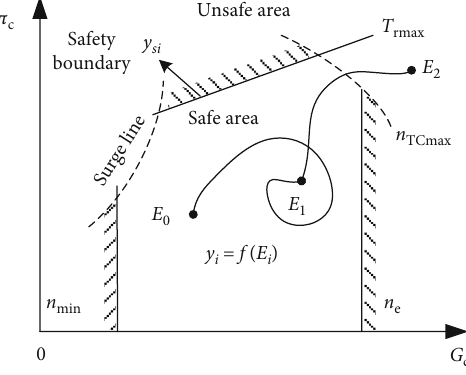
Figure 17: Relationship between the system operating state and safety